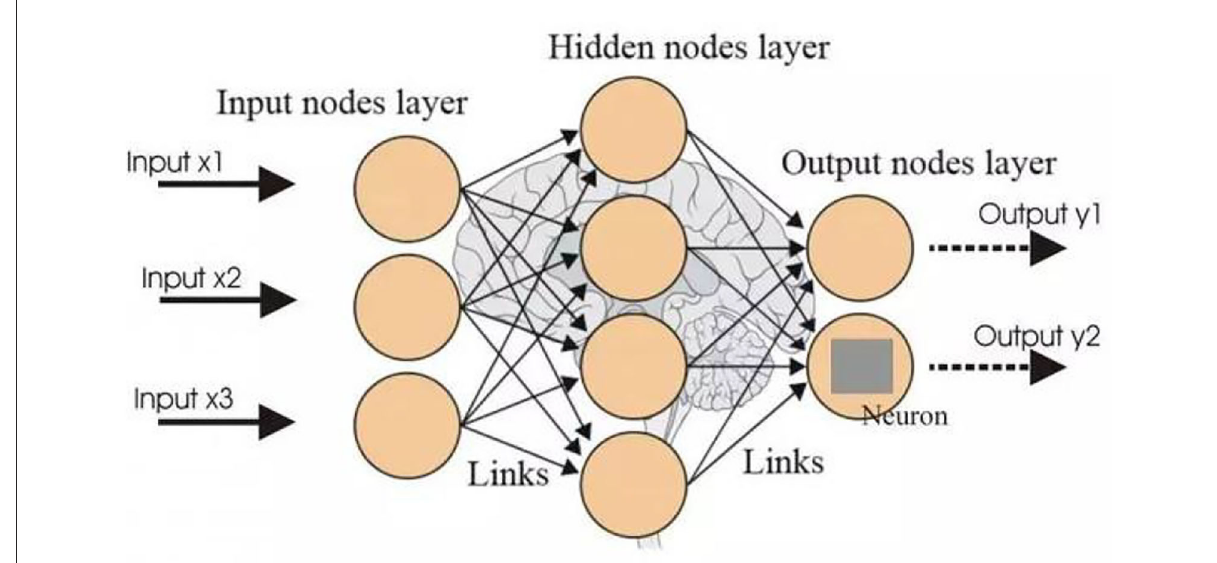
FIGURE1 BP neural network structure.